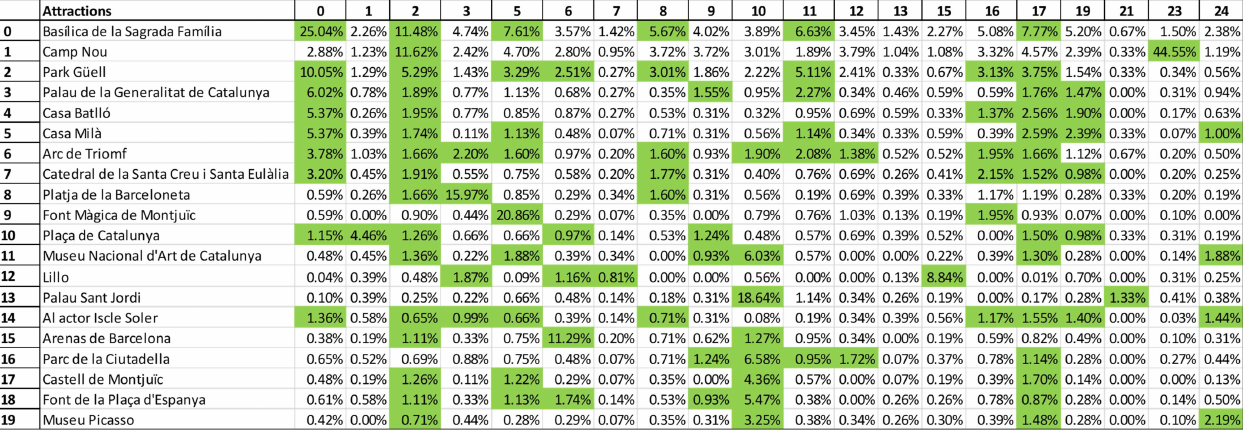
Figure 2. Top 20 most visited attractions and the percentage of their tweets per cluster, highlighting values above average in